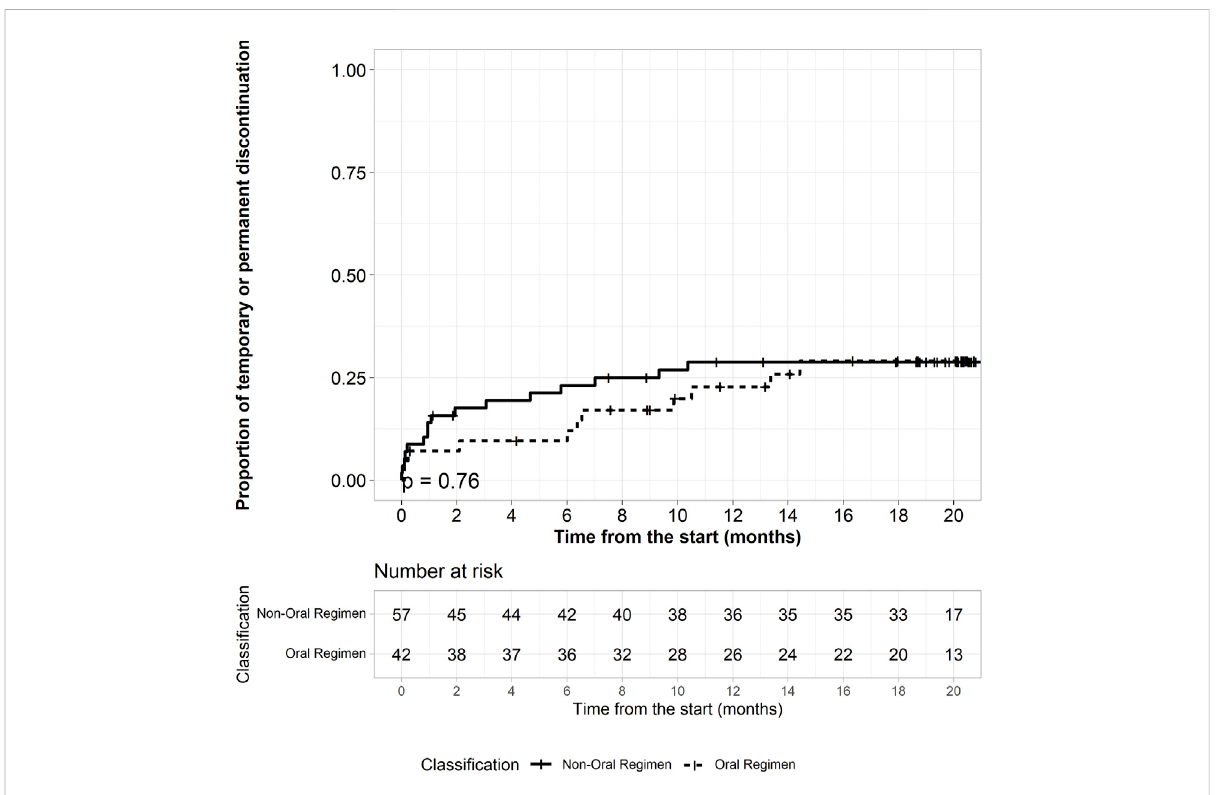
FIGURE 3 Time to temporary or permanent drug discontinuation by